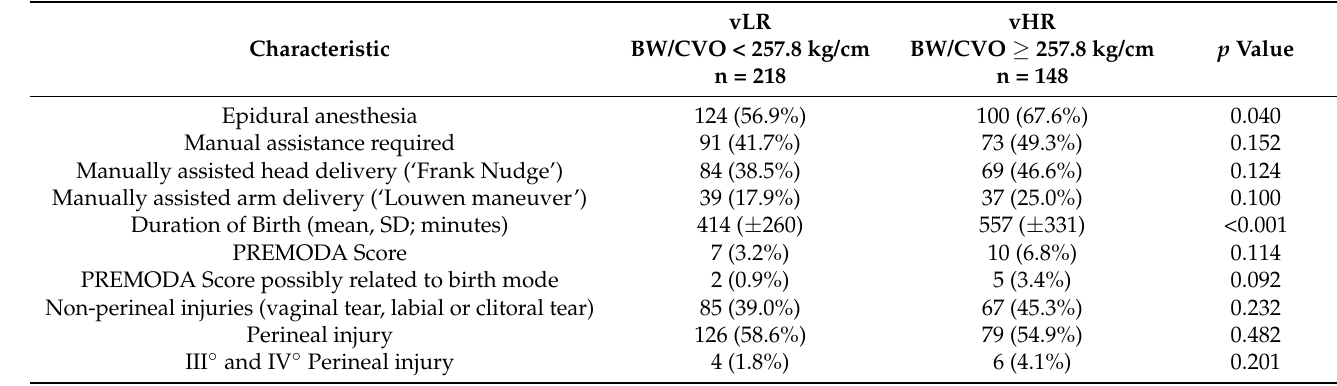
Table 4. Vaginal deliveries in an upright position–Outcome ( n = 366).